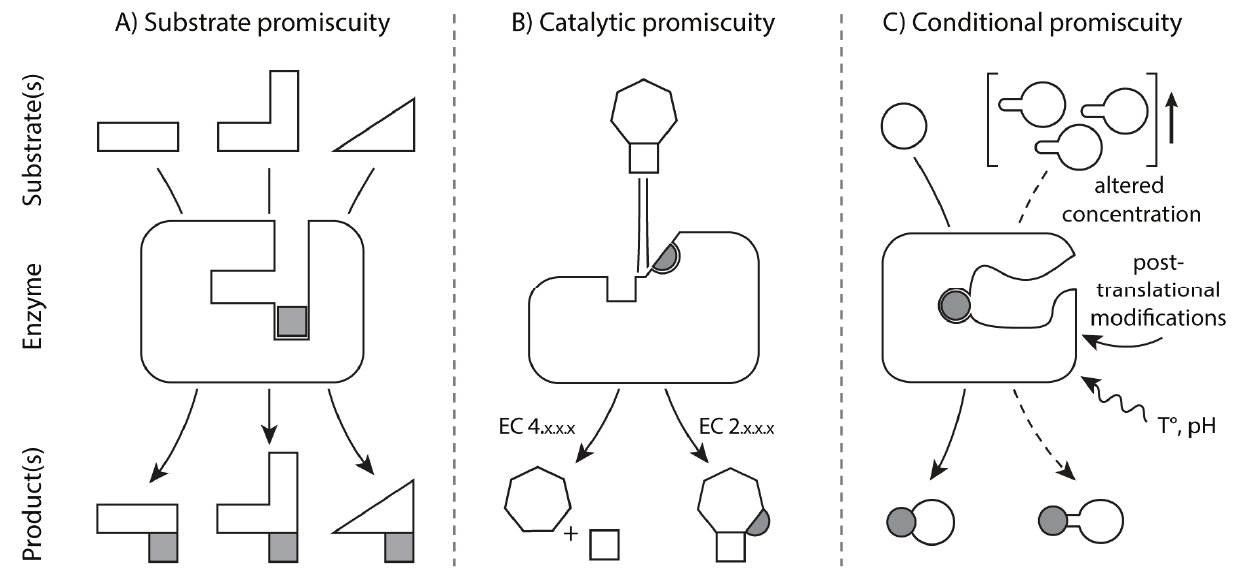
Figure 3. Mechanistic classification of enzyme promiscuity. ( A ) Substrate promiscuity or multispecificity: A certain enzyme can perform the same catalytic reaction on a diverse set of substrates indistinctly; ( B ) Catalytic promiscuity: Different chemical transformations are allowed by the same enzyme, according to which this can be classified with various